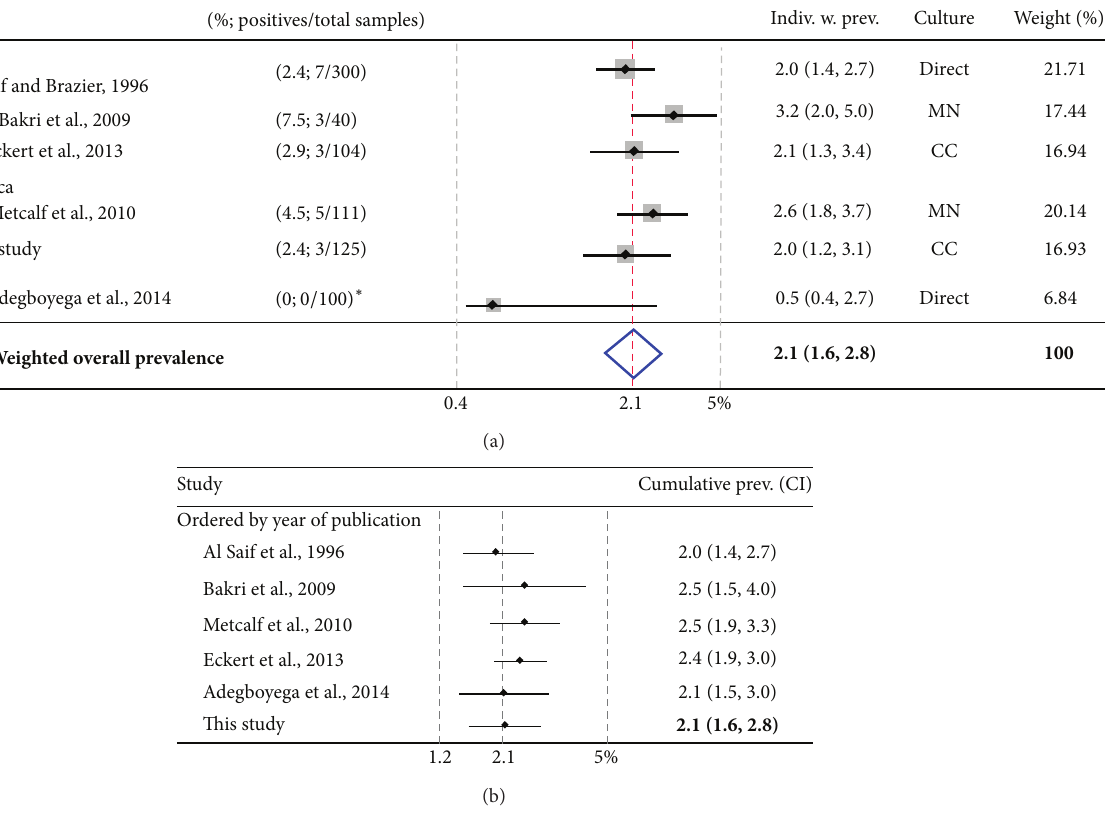
Figure 3: Systematic review and meta-analyses of C. difficile prevalence in vegetables for studies published between 1996 and 2014. (a) Forest plot of pooled meta-analysis with individual weighted estimates. Direct, MN, and CC indicate direct culture without enrichment, enrichment with moxalactam and norfloxacin (fluoroquinolone), or cycloserine/cefoxitin. With the inclusion of the Nigerian study [39], the (𝐼 2 ) study heterogeneity increased from low 7.7% to moderate 62.2% using cut off criteria as described [28]. Prior to its inclusion, the weighted overall prevalence of C. difficile was still very similar 2.3% (1.9, 2.6) to what is here reported with 6 studies. Asterisk: see methods for how zero prevalence studies were handled to enable the estimation of pooled parameters; study u s ed direct contact culture plating on Brazier CCEY Agar as described in first report of C. difficile in vegetables [10]. (b) Cumulative meta-analysis depicting changing estimated prevalence trend as studies become available. Note the comparable homogeneity across studies and the similar overall weighted prevalence. The inclusion of the Nigerian study as described in methods [33] had little effect on final cumulative prevalence (2.3%, CI = 1.9, 2.8, before